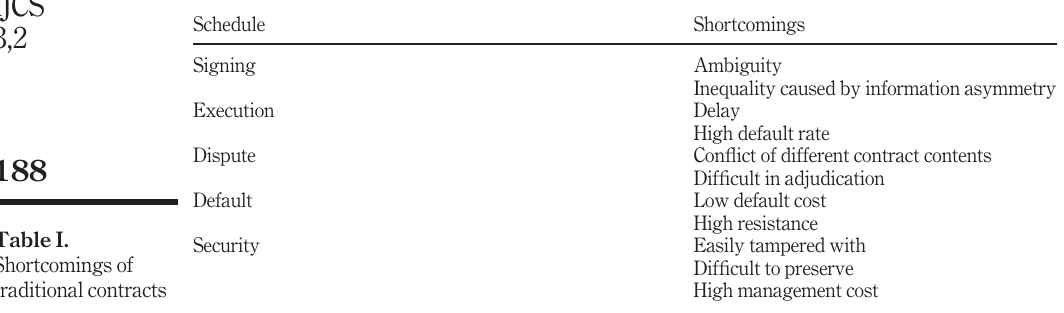
Table I. Shortcomings of traditional